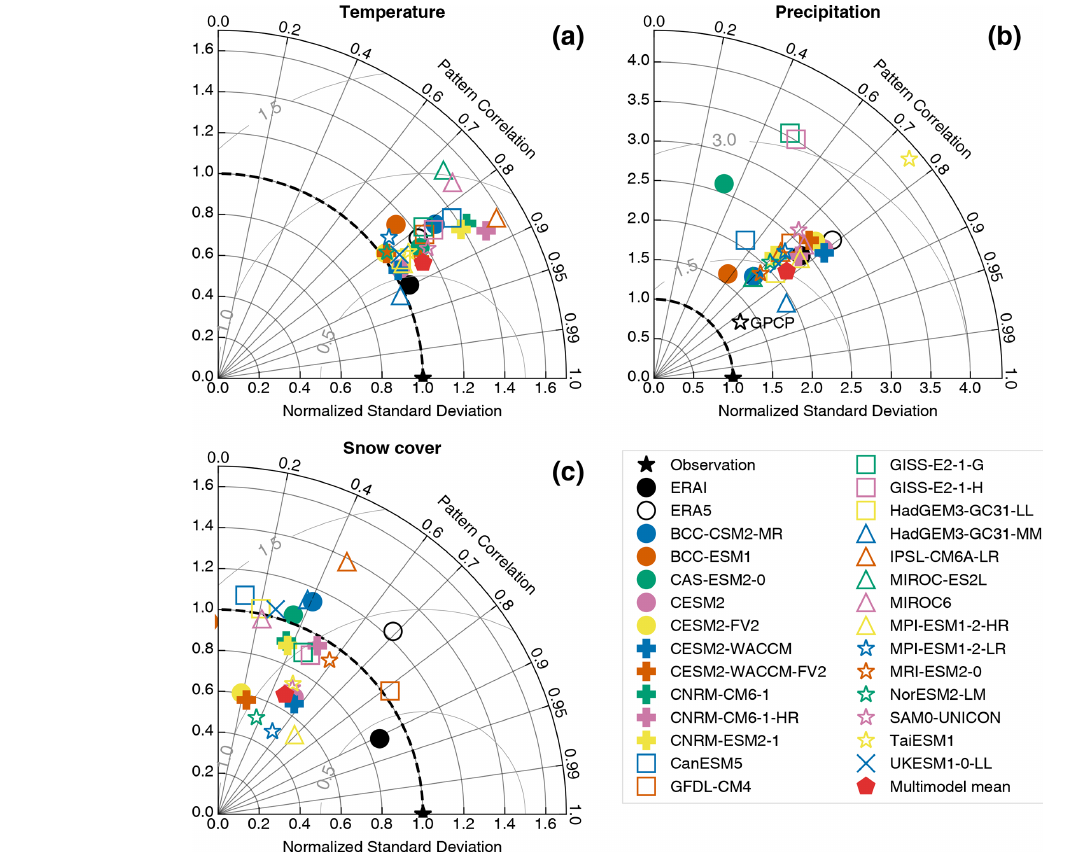
Figure 6. Taylor diagram showing for the 26 models over HMA the 1979–2014 mean of the spatial pattern of temperature (a) , precipi- tation (b) and snow cover (c) . The observational reference is shown with a black star corresponding to CRU (temperature), APHRODITE (precipitation) and NOAA CDR (snow cover extent). ERA-Interim and ERA5 are shown with the black circles filled and unfilled, respec- tively. The red pentagons correspond to the multimodel mean. The radial distance from the origin is proportional to the area-weighted standard deviation of the spatial pattern (normalized by the observation standard deviation). The area-weighted normalized centered RMSE between the model and the reference is proportional to the distance from the black star (light gray semi-circles). The area-weighted pattern correlation coefficient between the two fields is given by the azimuthal